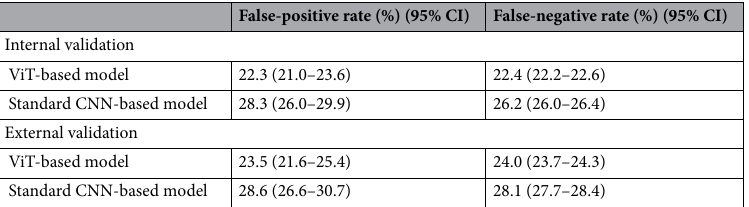
Table 3. Performance of the deep learning models in the false-positive rate and false-negative rate analysis. FPR false-positive rate, CI confidence interval, FNR false-negative rate, DL deep learning, ViT vision transformer, CNN convolutional neural network.